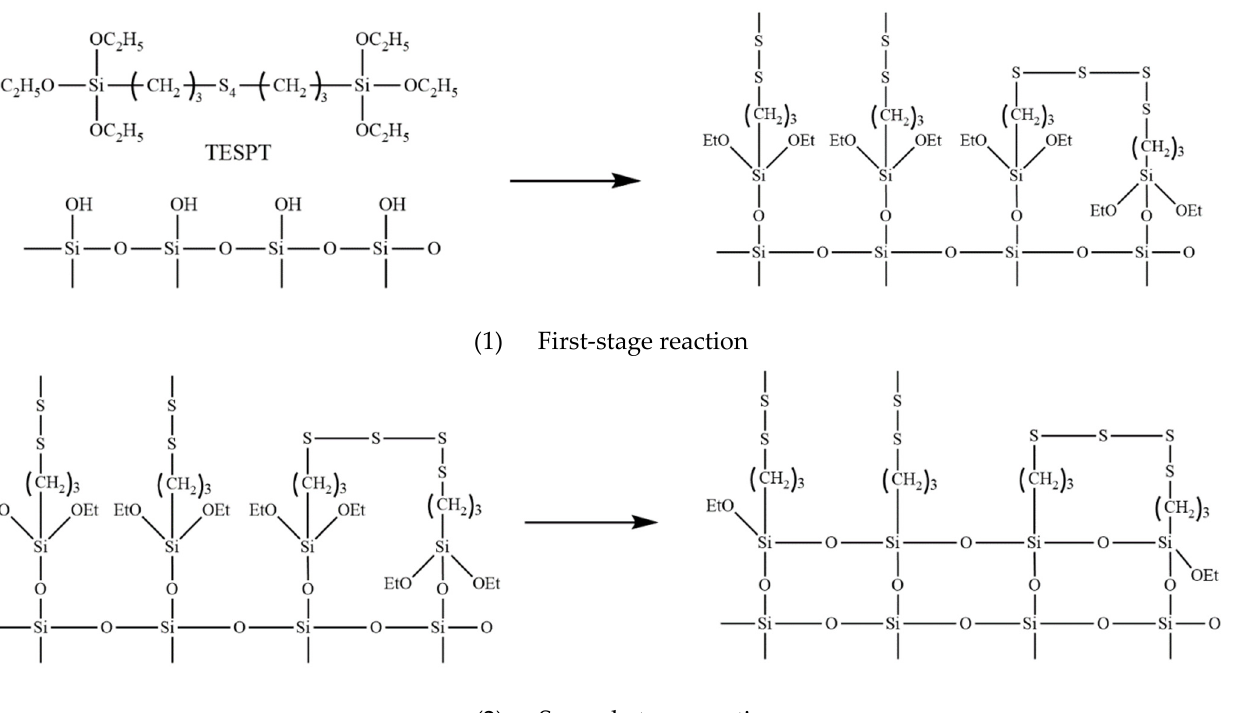
Figure 3. The silanization